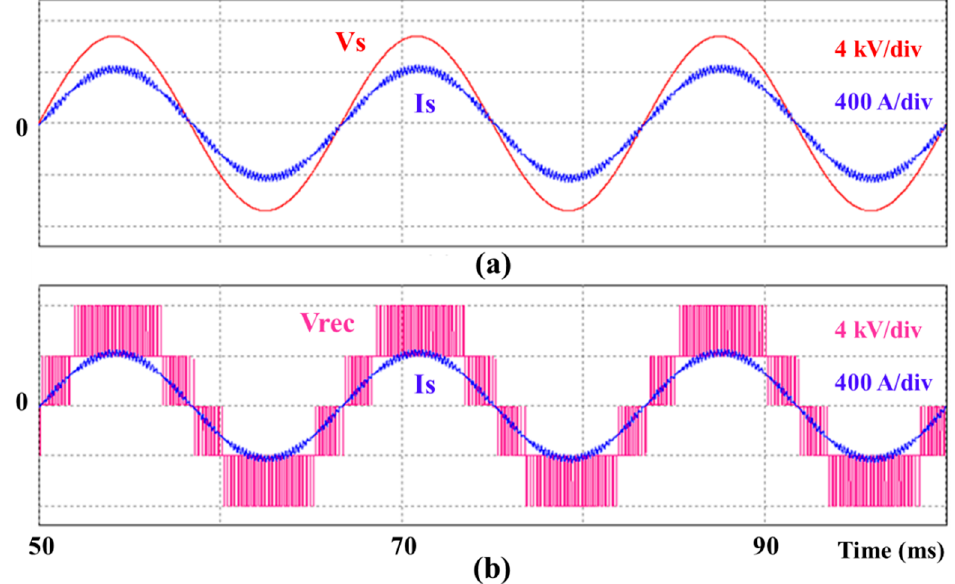
Figure 11. Simulation results for the five-level OCC MV Regen-Load waveforms with R load. ( a ) Input voltage and input current; ( b ) Rectifier voltage and input current.